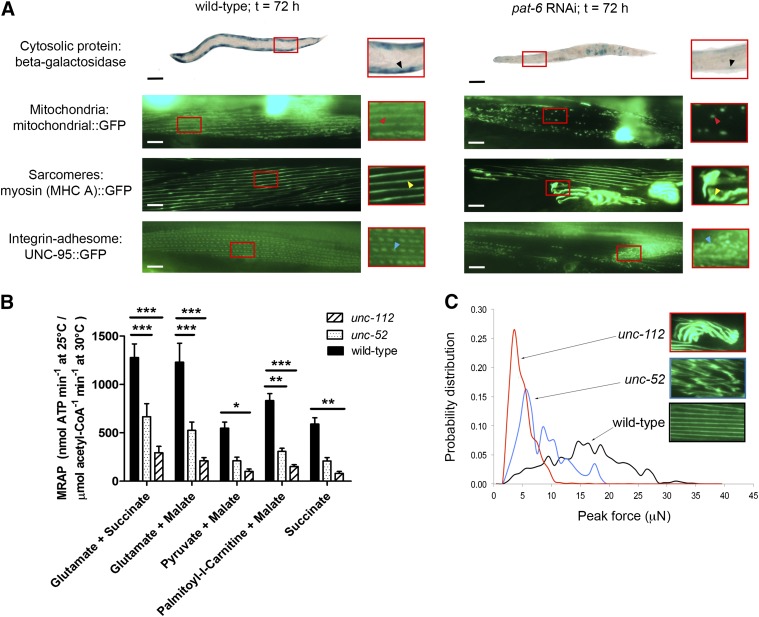
Muscle subcellular dystrophy relates to functional declines in mitochondrial maximal ATP production and voluntary muscle force. A) Examples of submuscular phenotypes scored for cytosolic protein content (first row), mitochondria (second row), sarcomeres (third row), and adhesomes (fourth row). The large, circular, overexposed regions in the mitochondrial images are GFP-labeled nuclei and are normal for the strain. Black arrowheads, normal cytosolic protein content (wild-type) and clearly reduced cytosolic report protein (pat-6 RNAi); red arrowheads, normal mitochondrial reticulum (wild-type) and near complete loss of reticular mitochondria (pat-6 RNAi); yellow arrowheads, normal myosin filament striation (wild-type) and myosin disorganization (pat-6 RNAi); blue arrowheads, normal integrin adhesion sites (wild-type) and loss of adhesion complex organization (pat-6 RNAi). Black bars, 100 μm; white bars, 10 μm. B) MRAP for wild-type animals vs. unc-52 and unc-112 mutants (n ∼ 250 animals per condition). Values represent means ± sem. Using 2-way mixed-model ANOVA with Bonferroni post hoc tests for pairwise comparisons: *P < 0.05; **P < 0.01; ***P < 0.001. C) Voluntary muscle force production and representative sarcomere structure in wild-type animals vs. unc-52 and unc-112 mutants.